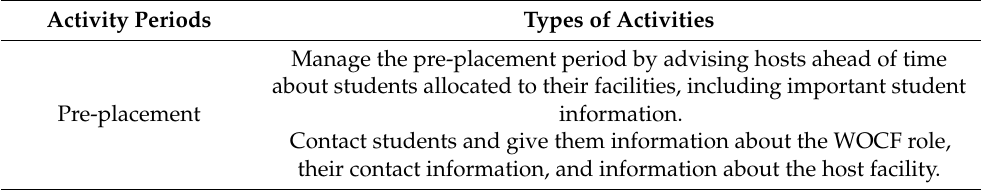
Table A1. General activities of